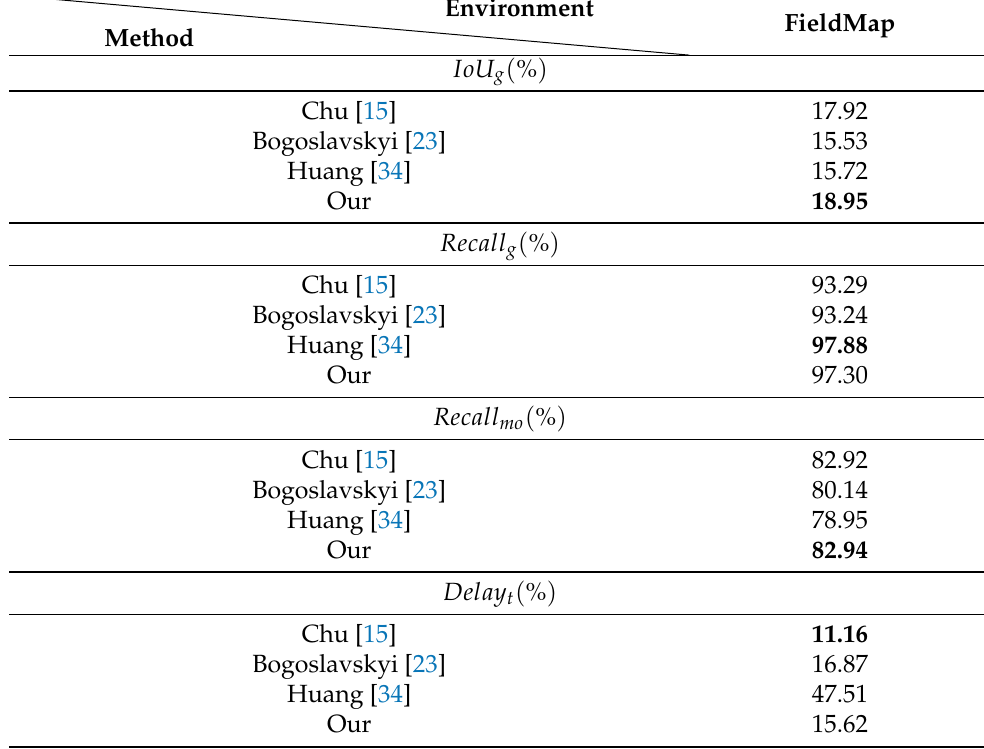
Table 4. The evaluation results on the self-made